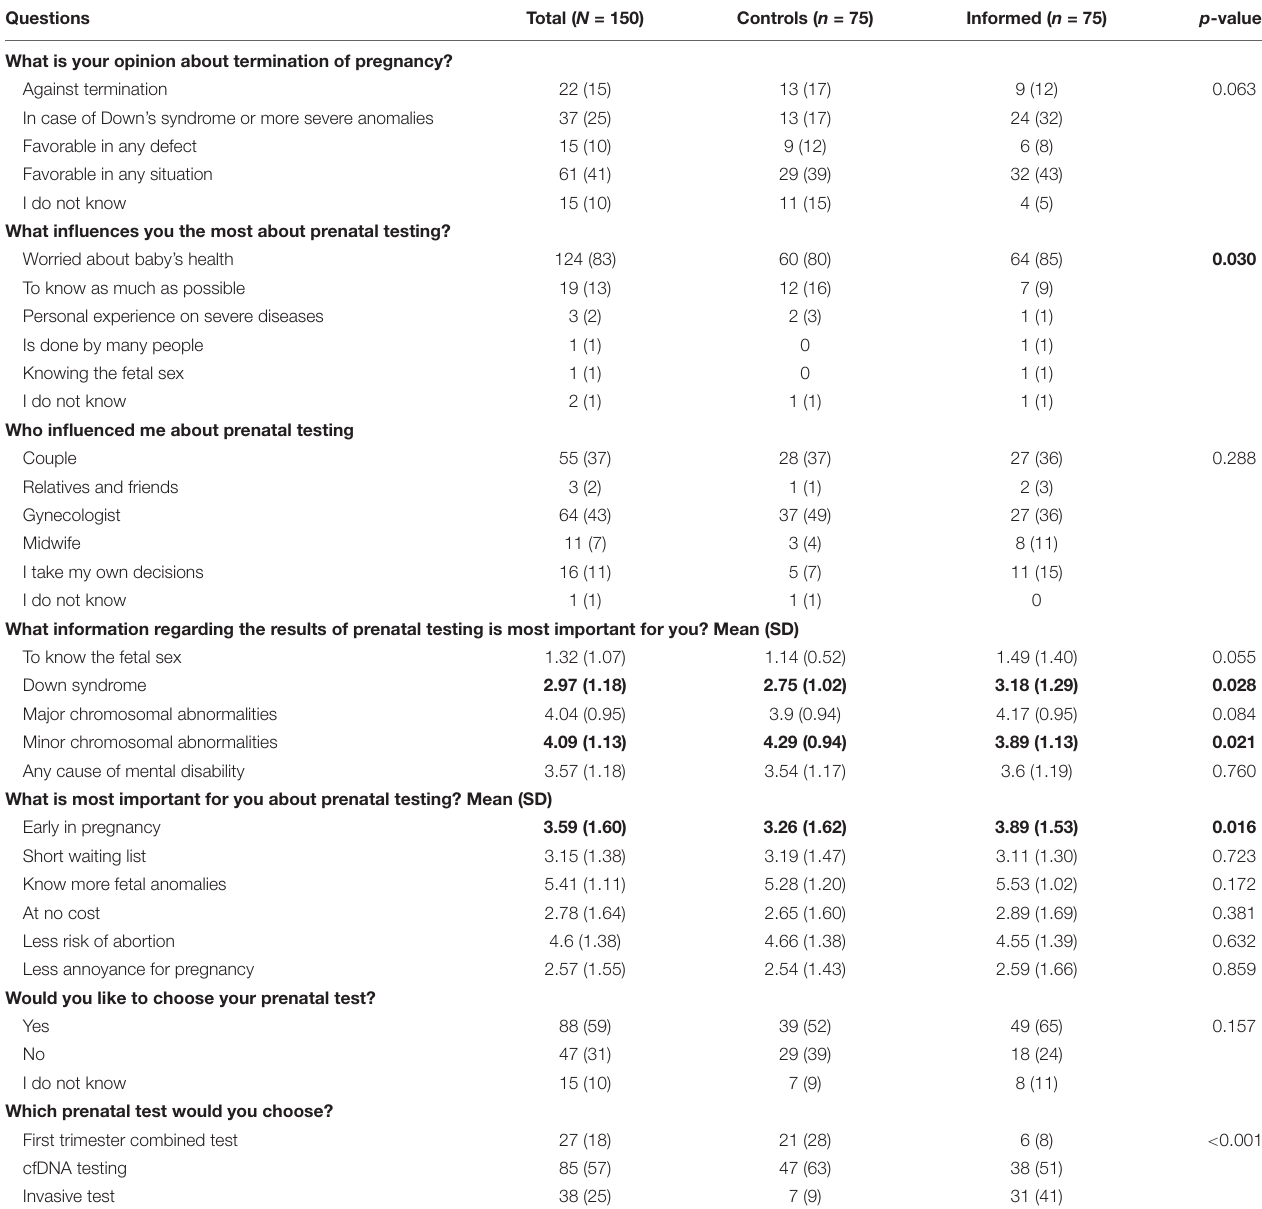
TABLE 2 | Questions about the knowledge and preferences regarding prenatal